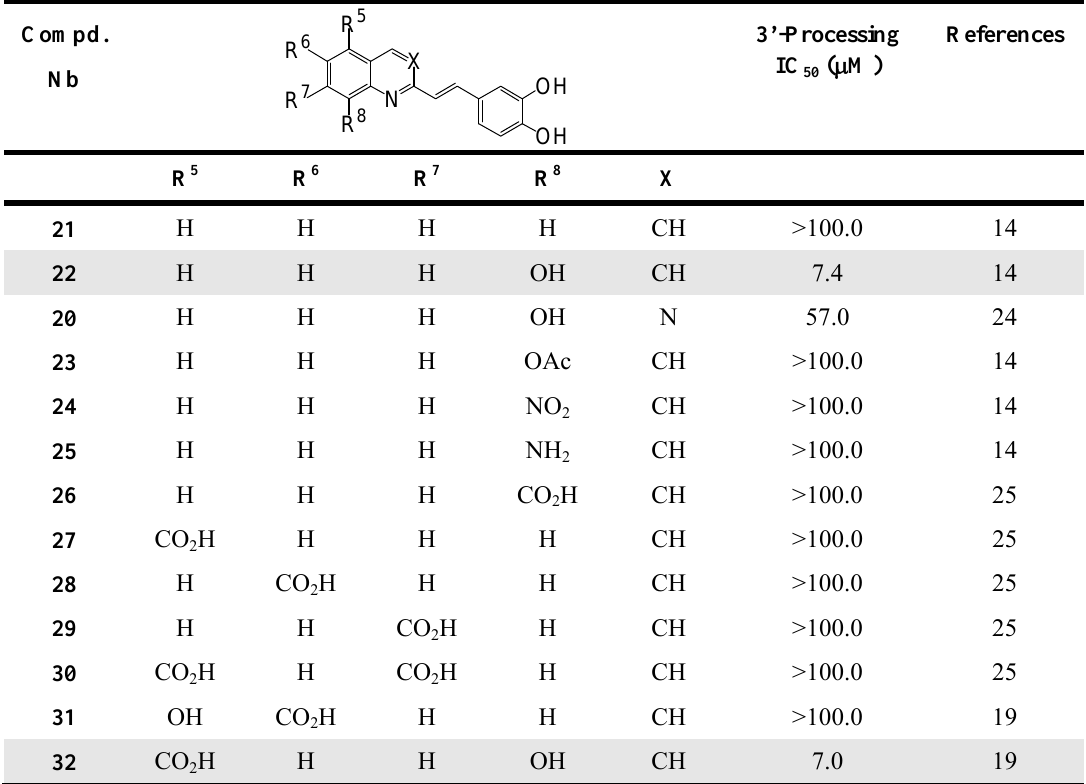
Table 2. HIV-1 IN inhibitory potency of various 3',4'-dihydroxystyrylquinolines.